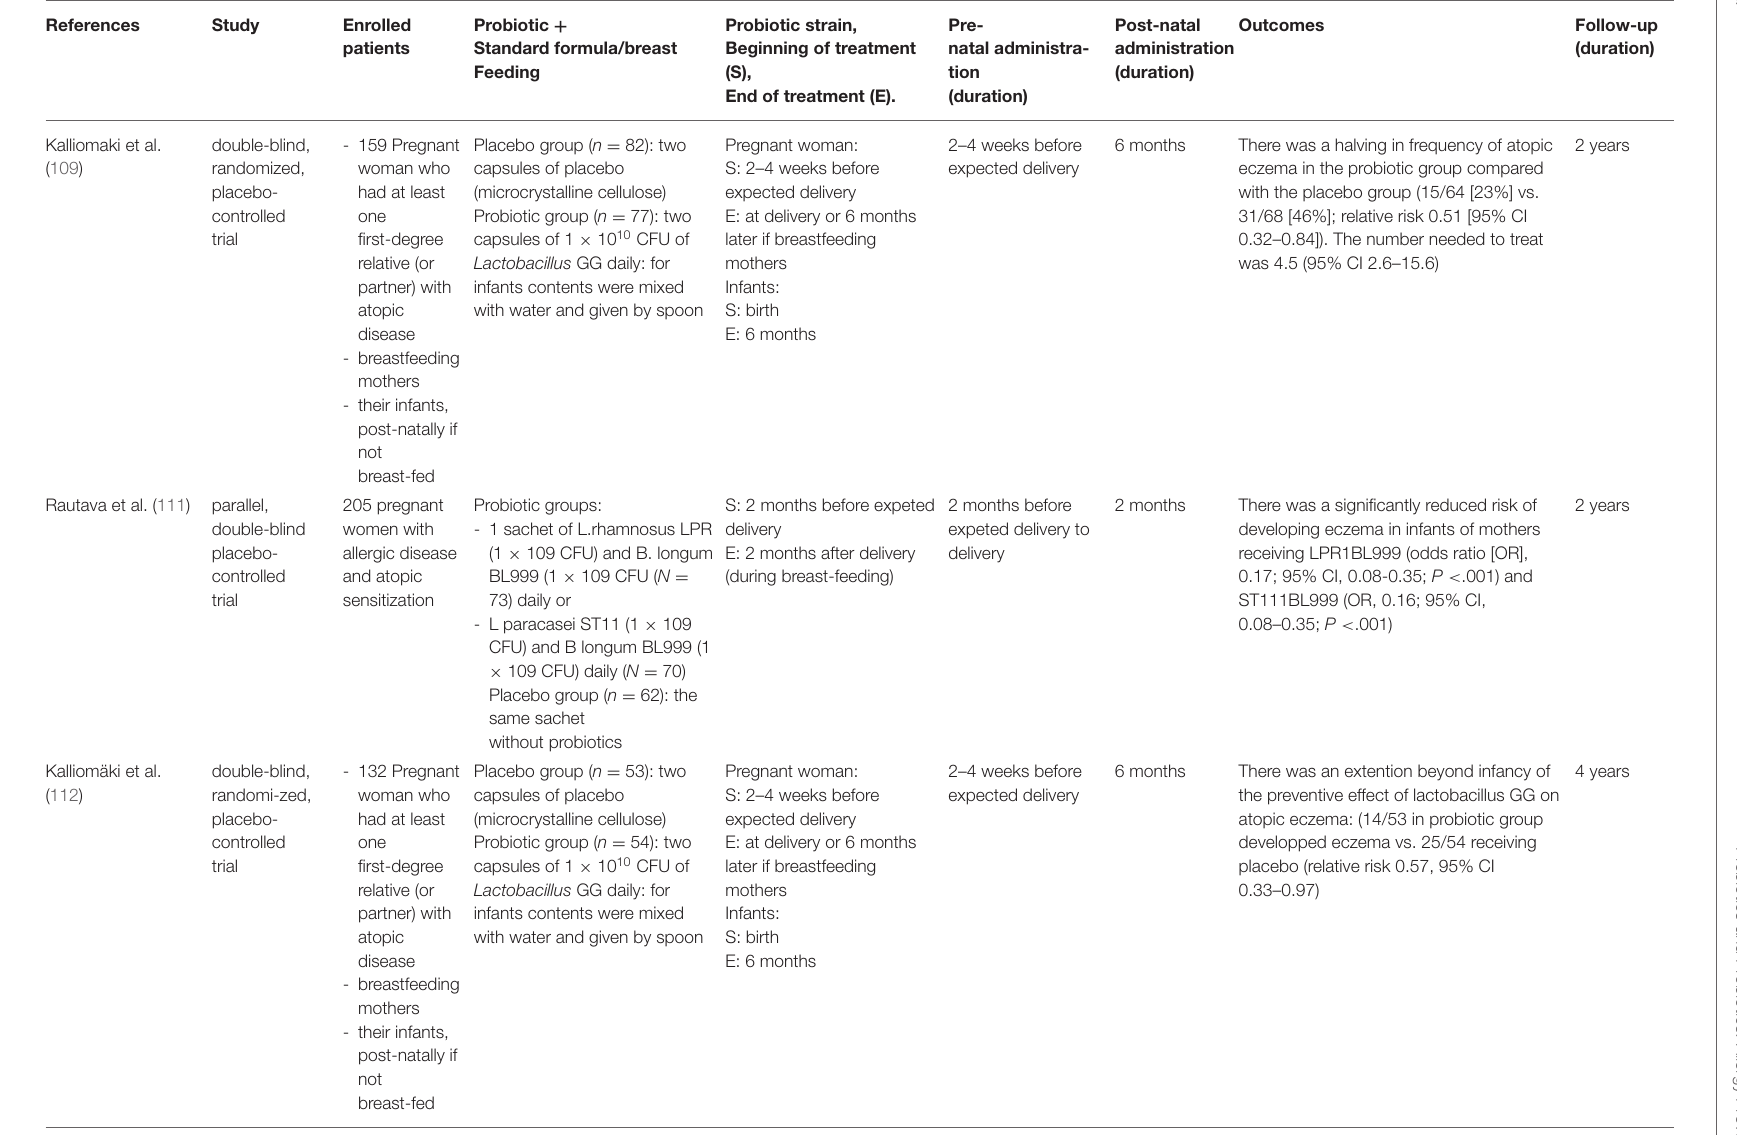
TABLE 2 | Probiotics administration in prevention of allergic disorders. (A) Probiotic given orally (eg droplets, suspensions, capsules) or with breastfeeding/ standard